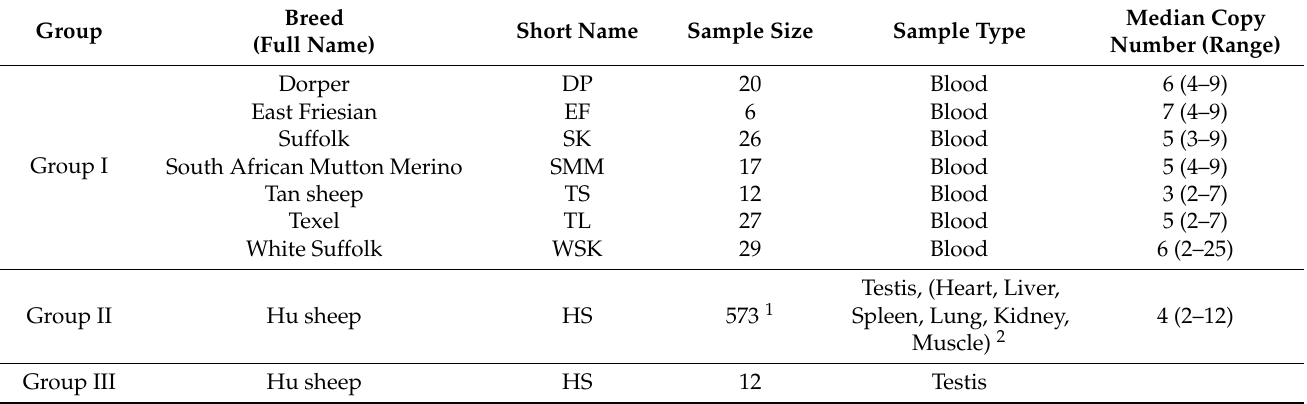
Table 1. Sample information and the median copy number of PRAMEY in 8 sheep